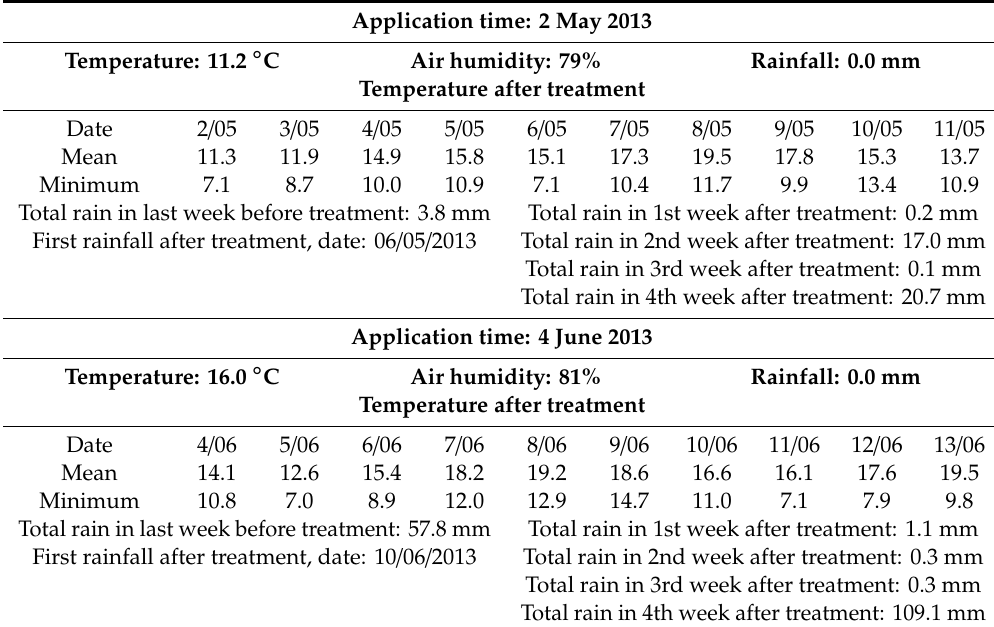
Table 2. Meteorological data at the Research and Education Center Brody during and after spray application in 2013 and